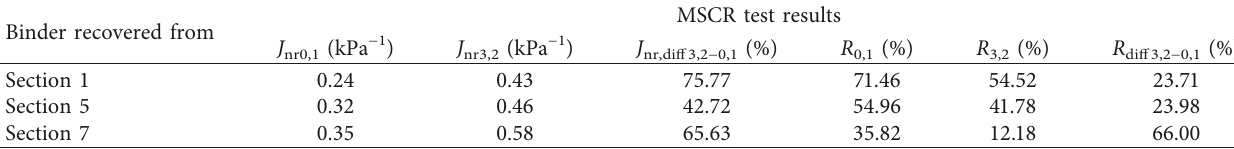
Table 8: Results of multiple stress creep and recovery test according to EN 16659 for selected recovered binders. Binder recovered from